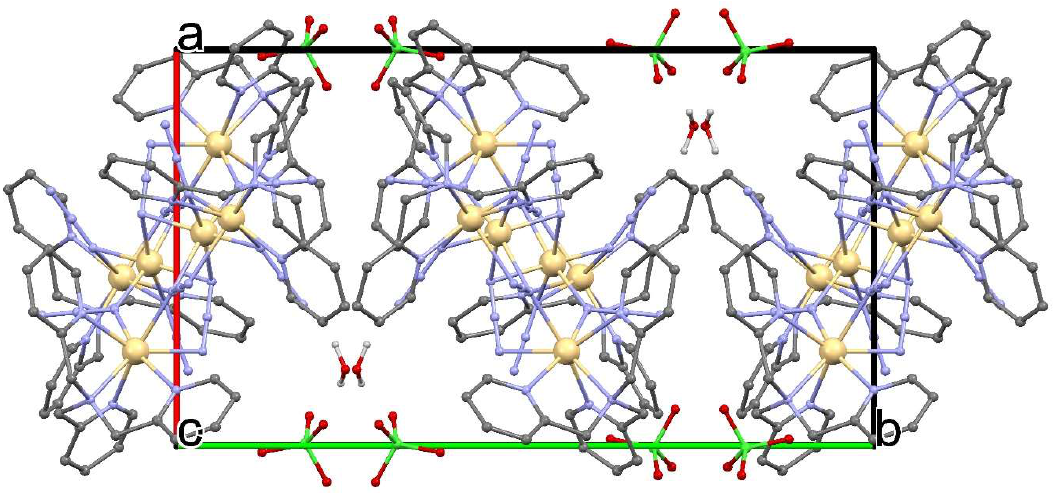
Figure 3. Packing plot of [Cd 6 (TPA) 4 (μ 3 -1,1,3-N 3 ) 4 (μ 2 -1,1-N 3 ) 6 ](ClO 4 ) 2 ·2H 2 O ( 1 ).